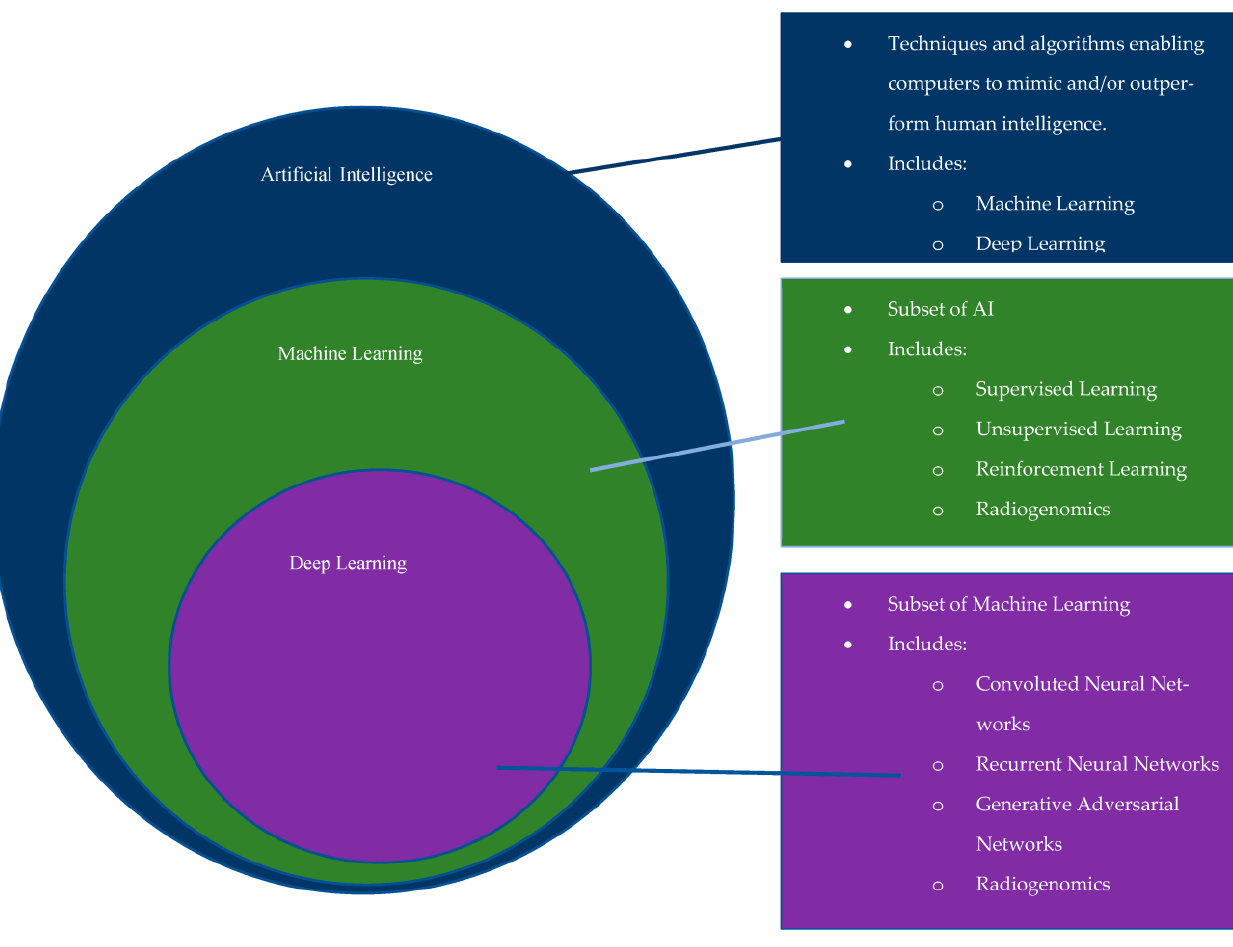
Figure 1. Schematic outlining the relationship between AI, ML, and DL, as well as aspects that make up each of them individually.